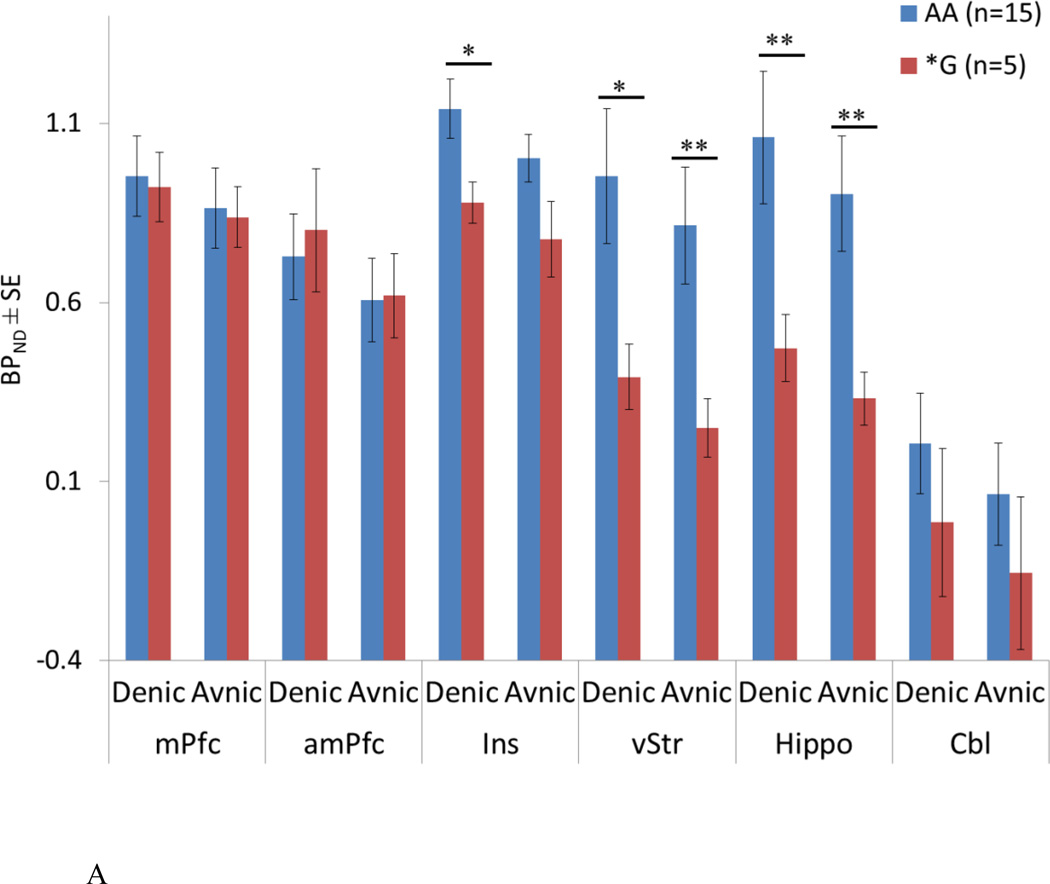
A.OPRM1 A118G effects on increases in endogenous mu opioid releaseB.OPRM1 A118G effects on decreases in endogenous mu opioid release